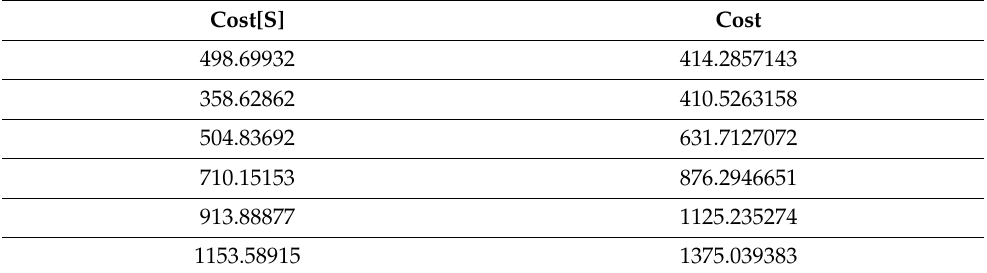
Table A4. The comparison between the estimated costs and the theoretical